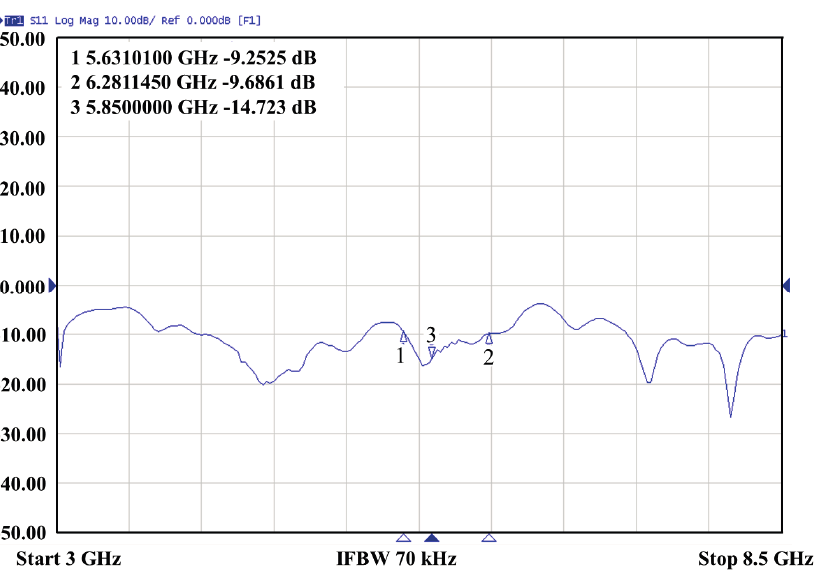
Figure 7. Measurement result of return loss.